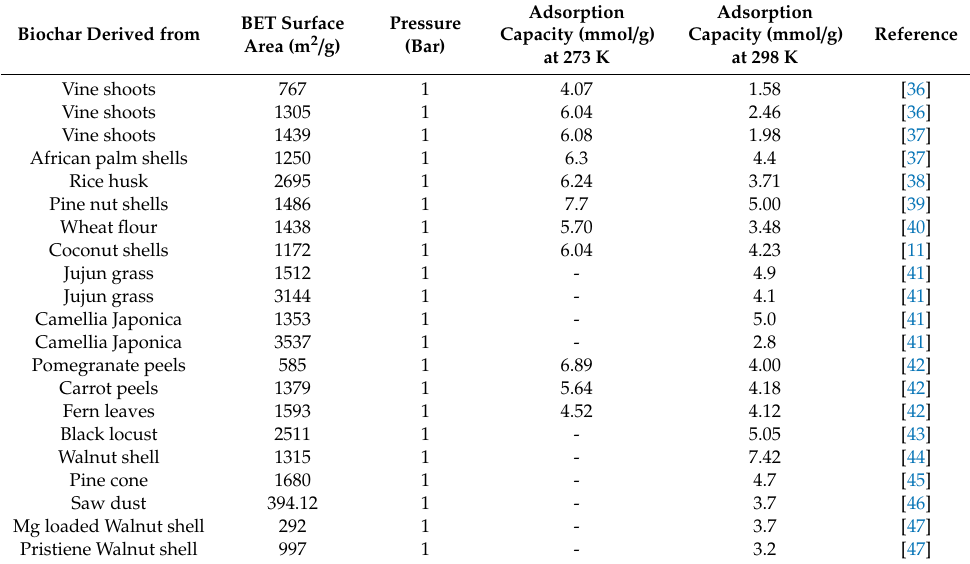
Table 1. CO 2 capture performances by top performance biochar produced from di ff erent biomasses and at di ff erent conditions. The surface area is based on Brunauer–Emmett–Teller (BET). Adsorption Adsorption BET Surface Pressure Capacity (mmol / g) Capacity (mmol / g) Reference Biochar Derived from Area (m 2 / g) (Bar) at 298 K at 273 K Vine shoots 767